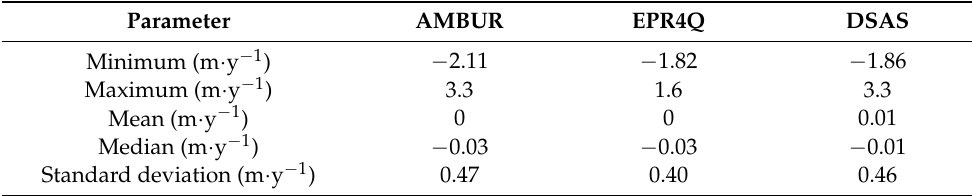
Table 3. Statistical parameters between the different tools applied to the Arlight shoreline.